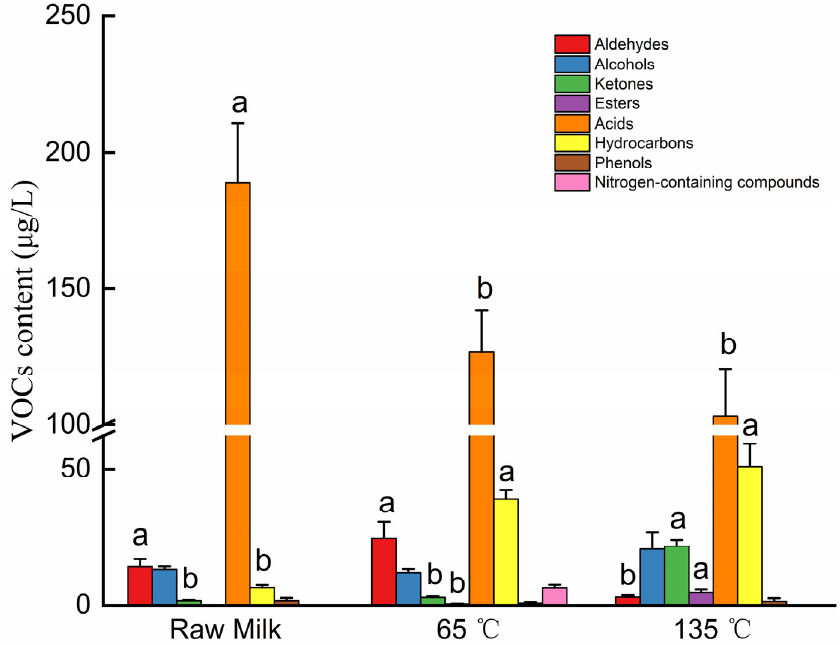
Figure 4. Changes in VOC content in milk under different temperatures. Different lowercase letters represent significant differences at p < 0.05.